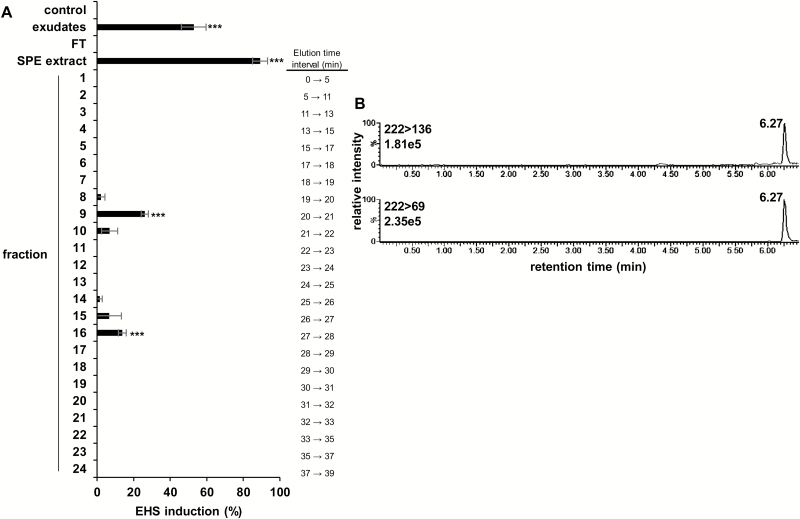
Fractionation of B. napus root exudates. (A) Distribution of EHS induction activity after RP-HPLC fractionation of SPE concentrated B. napus root exudates. Half-diluted exudates and SPE extracts (1000-fold diluted) were used as positive controls, Coïc medium was used as negative control. HPLC-purified fractions were 100-fold diluted. All dilutions were performed in buffer solution (0.5 mM HEPES, 0.05% PPM). Means are values ±SE (n=3). Means annotated with asterisks are significantly different from the negative control (t-test, ***P<0.001). (B). UPLC-ESI(+)-MS/MS analysis of fraction 9 detected in the MRN channel of DHZ.